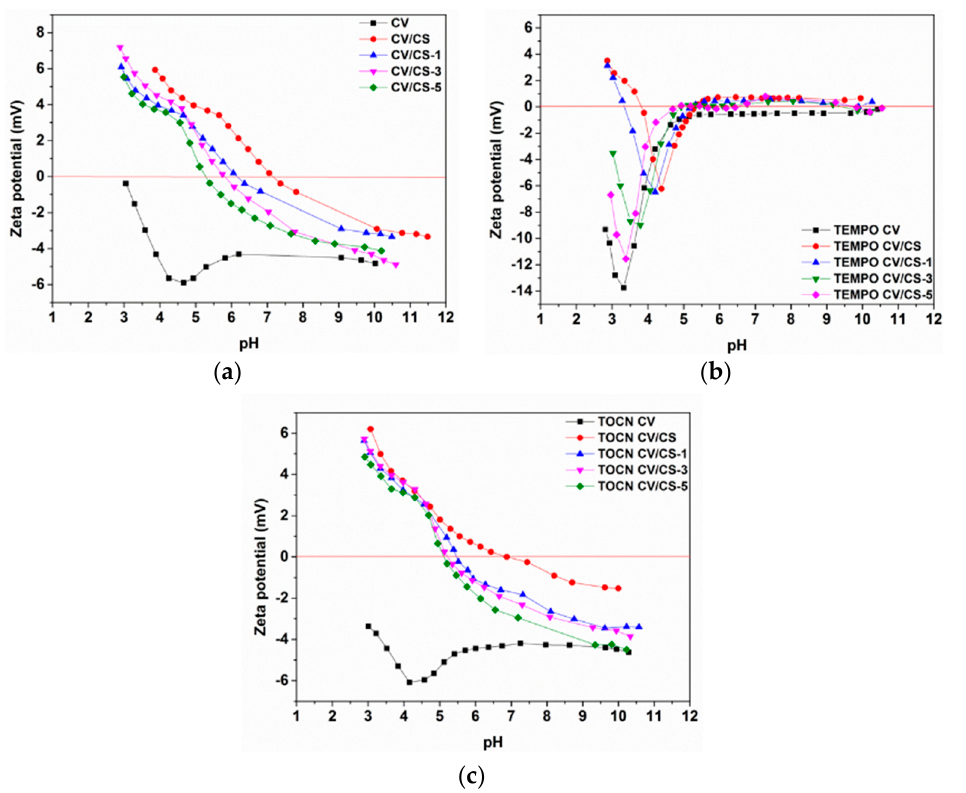
Figure 5. Zeta potential of pristine ( a ), TEMPO oxidized ( b ) and TOCN coated ( c ) viscose fabrics functionalized with chitosan before and after one, three and five washing cycles.